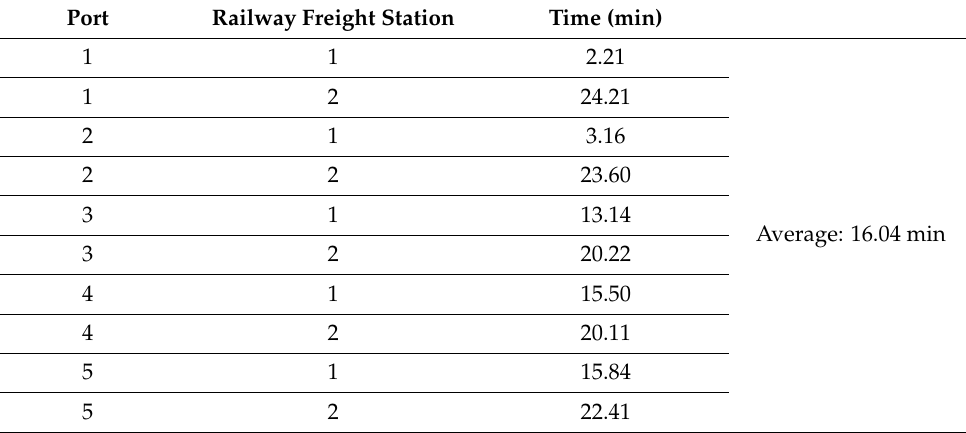
Table 3. Planning port-railway freight station transfer time statistics.